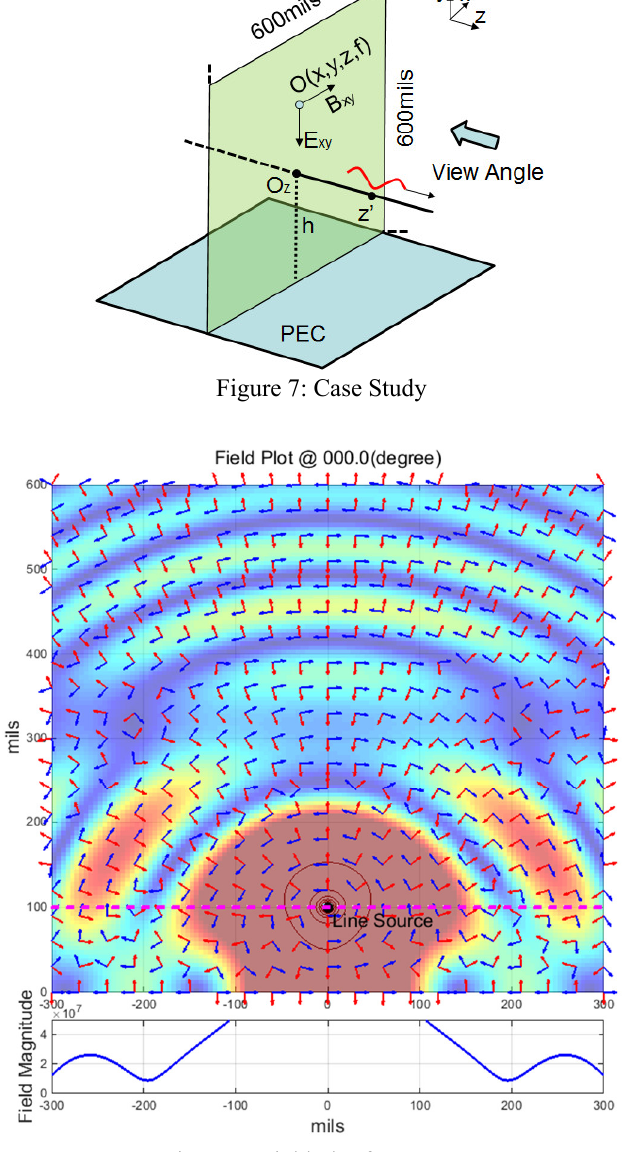
Figure 8: Field plot for 100 GHz